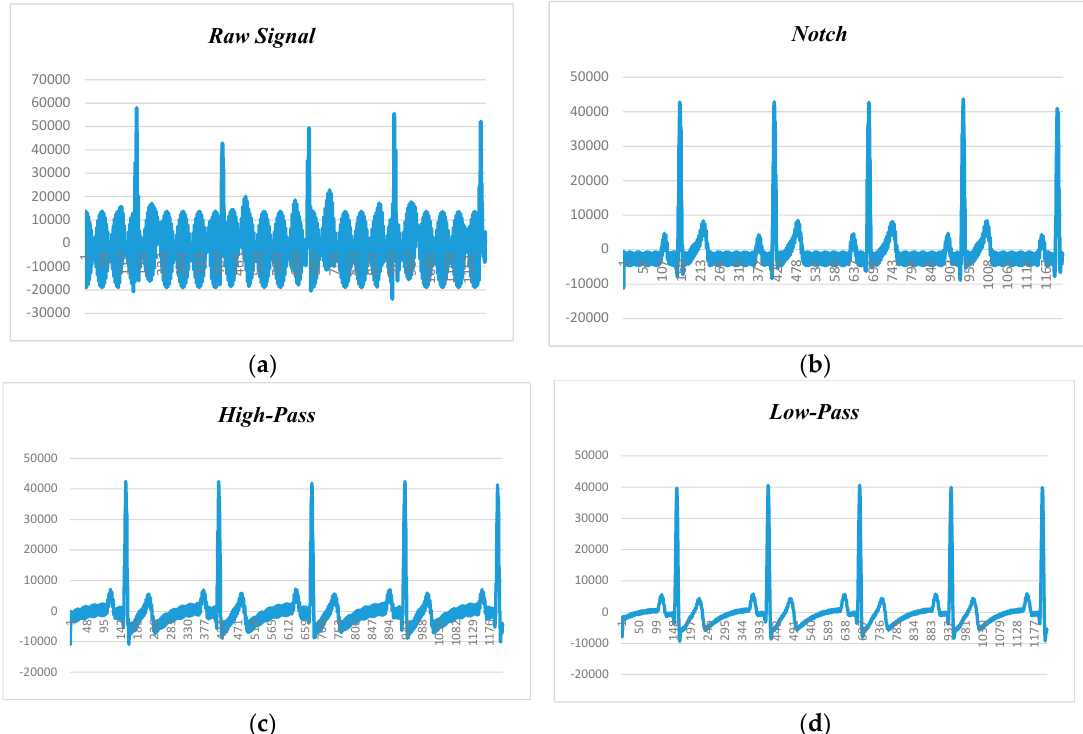
Figure 9. ECG data filtering at 60 BPM and 60 Hz noise: ( a ) raw data; ( b ) notch filter; ( c ) high-pass filter (HPF); ( d ) low-pass filter (LPF).